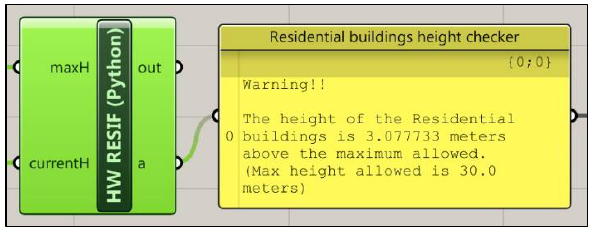
Figure 10. Example of warning issued by the tool to inform the user that the building height is exceeding the limit allowed.